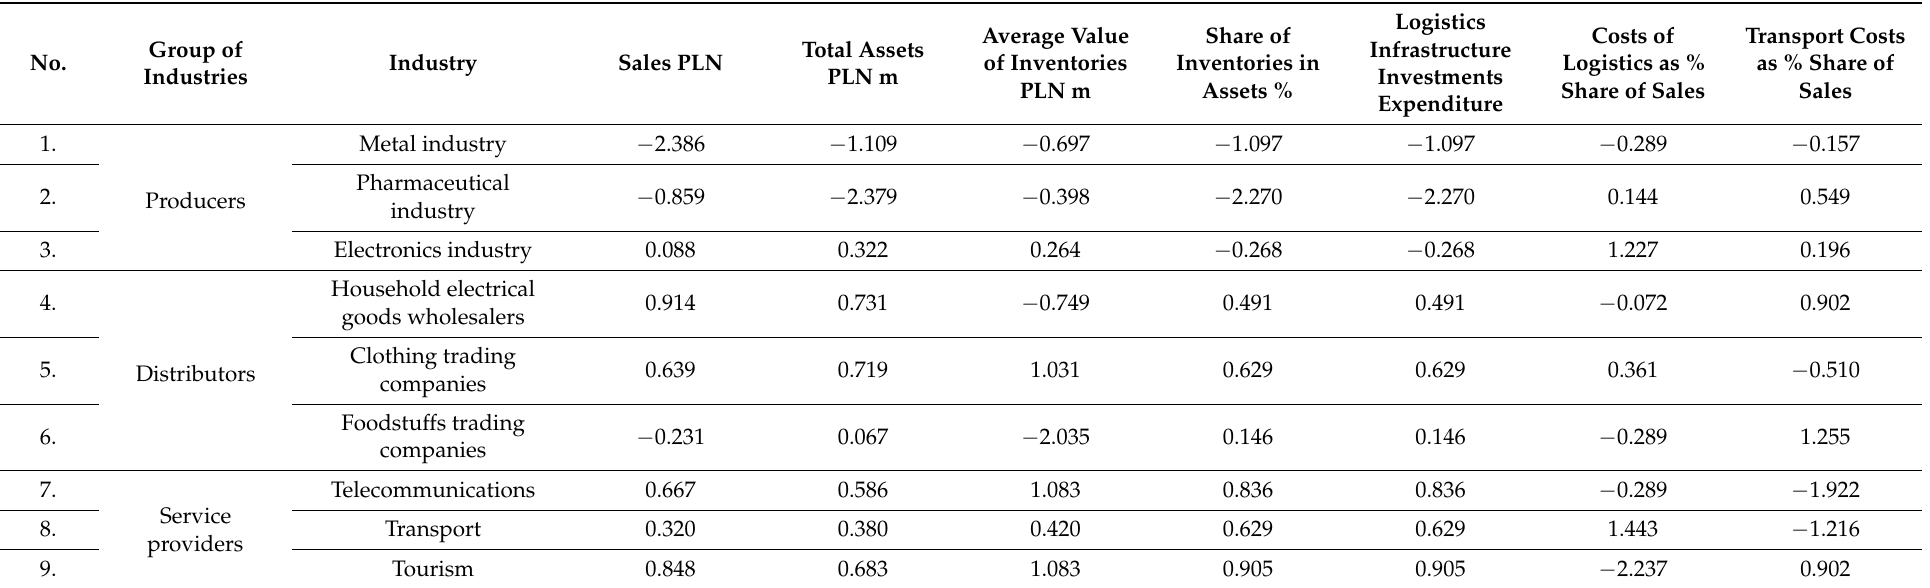
Table 6. Transformed indicators of company logistics